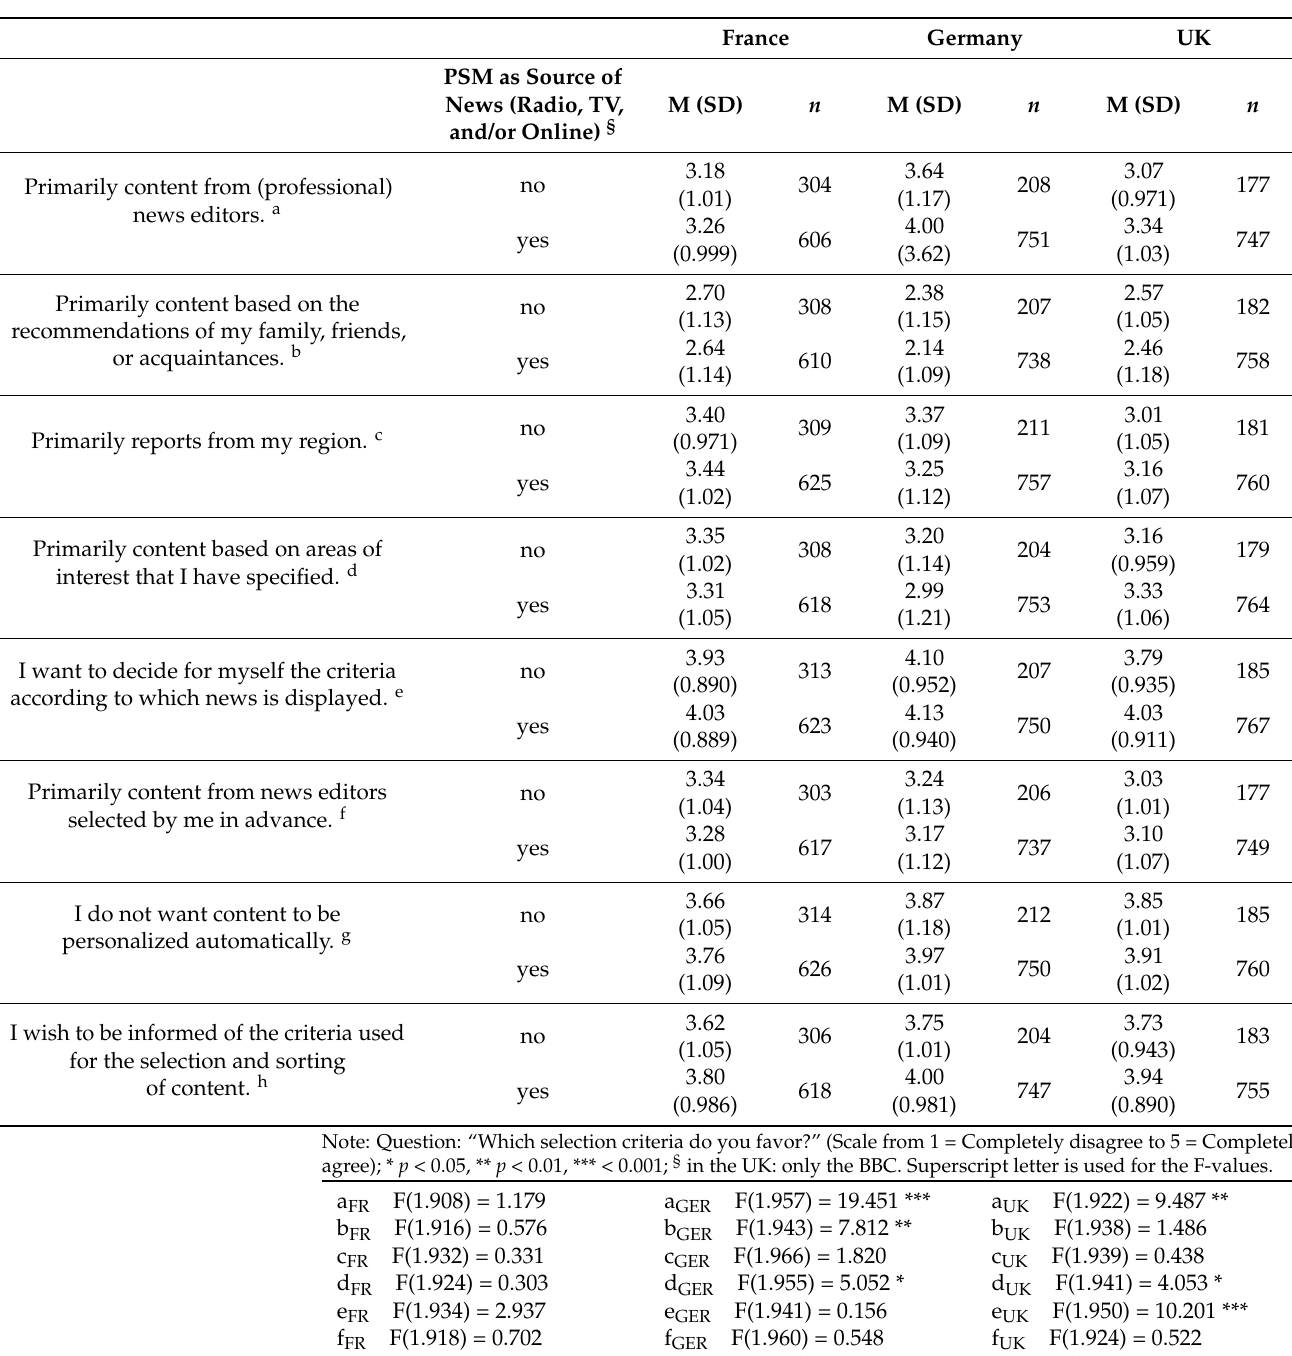
Table 4. Preferred criteria for news